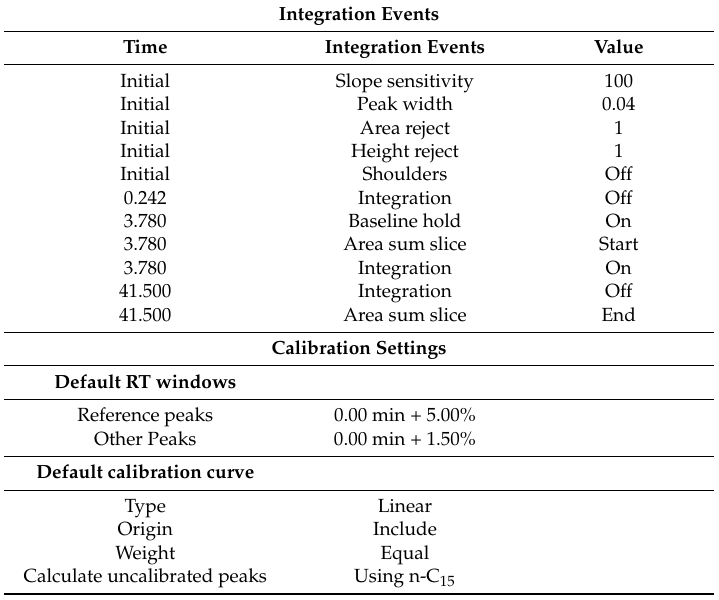
Table 2. Integration events and calibration settings for